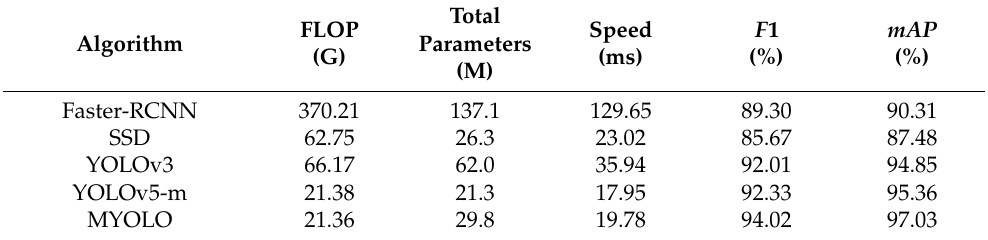
Table 5. Algorithm detection performance comparison (IoU threshold set to 0.5).